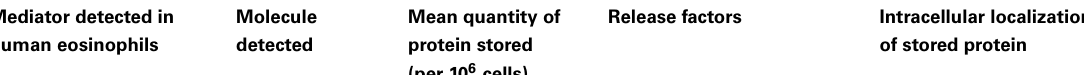
Table 1 | Eosinophil-derived cytokines, chemokines, and growth factors